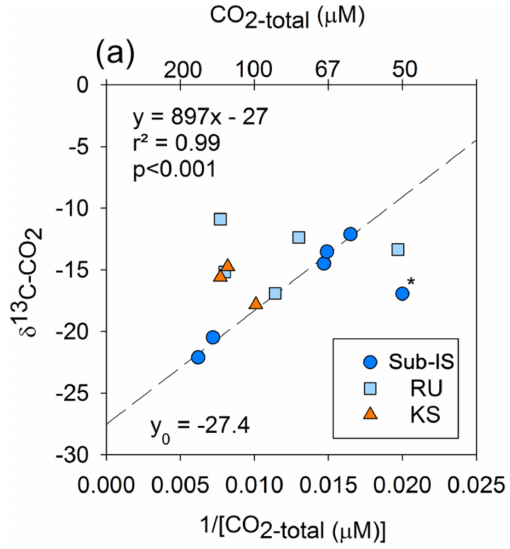
Figure 9. Keeling plot indicating correlations between the magni- tude of CO 2-total and δ 13 C-CO 2 and for sub-Isunnguata (sub-IS), Russell (RU), and Kiattut Sermiat (KS) samples. Asterisk denotes the outlier not included in the regression between CO 2-total and δ 13 C-CO 2 for sub-Isunnguata samples. The plotted regression line was constructed using the sub-IS samples